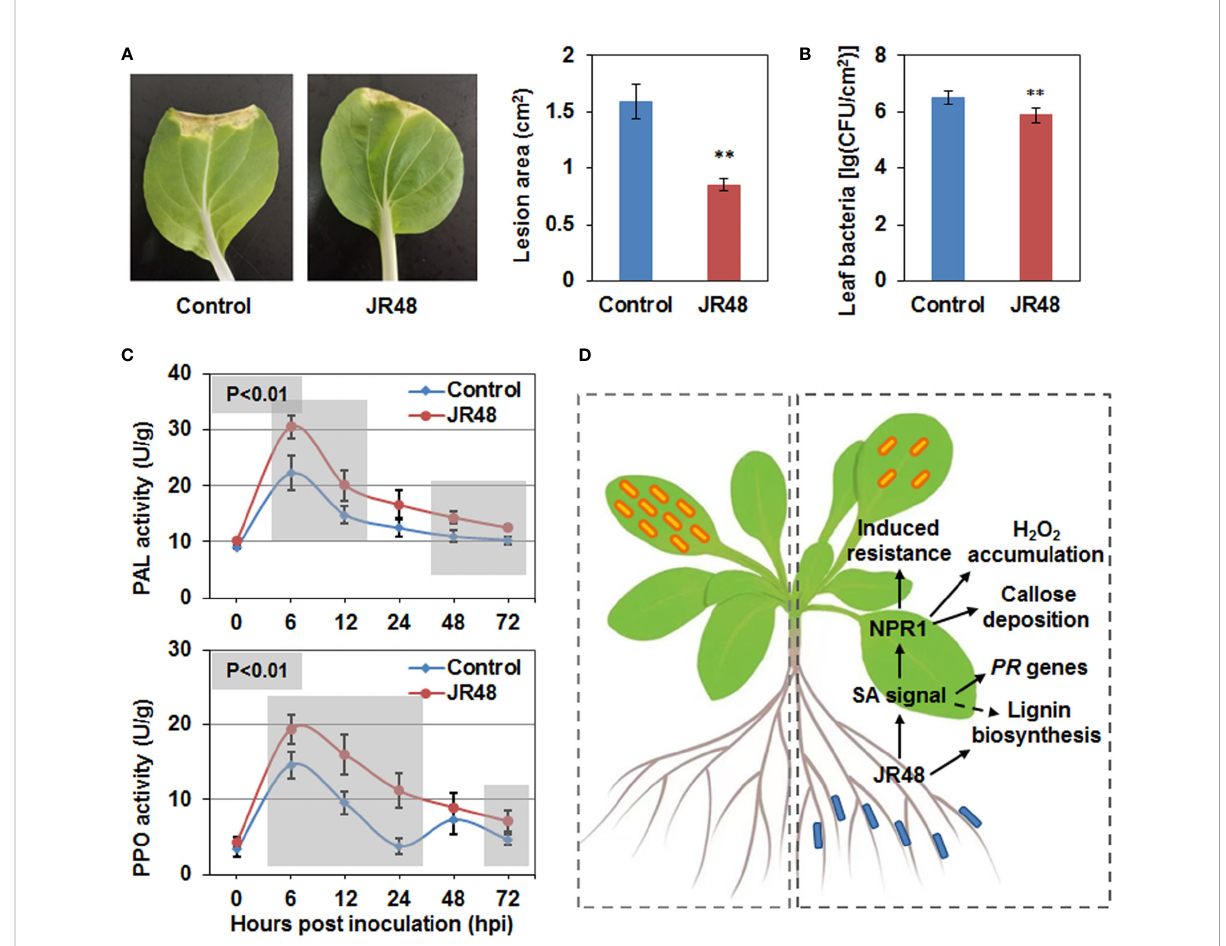
FIGURE 7 Enhanced plant resistance by JR48 on Chinese cabbage. (A, B) Disease symptoms and bacterial infection on Chinese cabbage. Suspensions of Xcc 8004 were inoculated on leaves of pre-treated Chinese cabbage by clipping. Representative photographs (A) were taken at 10 days post inoculation, lesion area were measured at the same time. Data presented are means ± SD (n ≥ 16), ** indicates signi fi cant differences (P < 0.01, Student ’ s t -test). Populations of leaf bacteria (B) were counted at 5 days post inoculation (mean ± SD; n ≥ 6; **P < 0.01, Student ’ s t -test). This experiment was repeated three times with similar results. (C) Activities of defense-related enzymes during pathogen infection. Chinese cabbage plants were pre-treated and inoculated with Xcc 8004 after 3 days. Leaf tissues near the incision were homogenized to determine the activities of PAL and PPO at the indicated time points. The values are means ± SD (n ≥ 12) and signi fi cant differences (**P < 0.01) were assessed with Student ’ s t -test. Experiments were repeated in triplicate. (D) A schematic diagram illustrating that JR48 induces plant resistance and